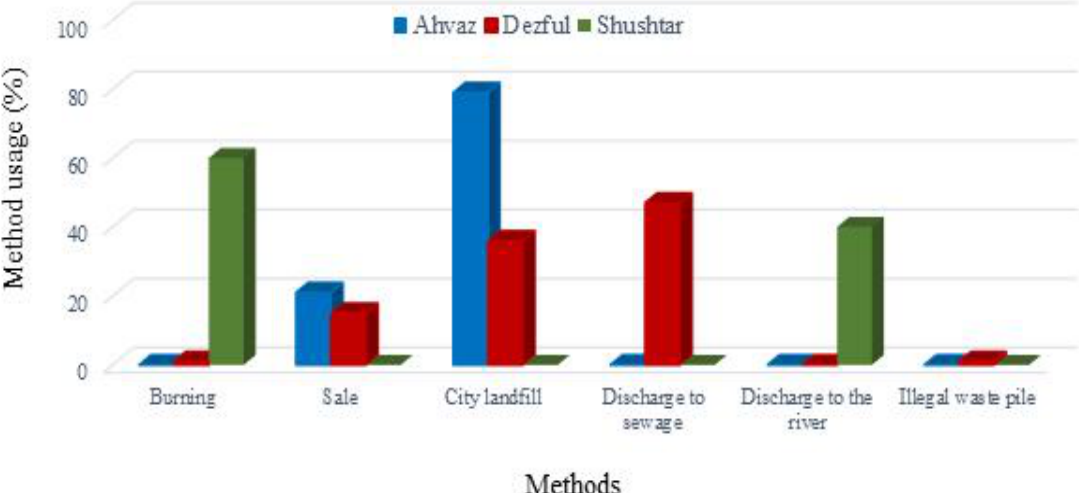
Fig. 2: The disposal methods of waste in each of Ahvaz, Dezful and Shushtar